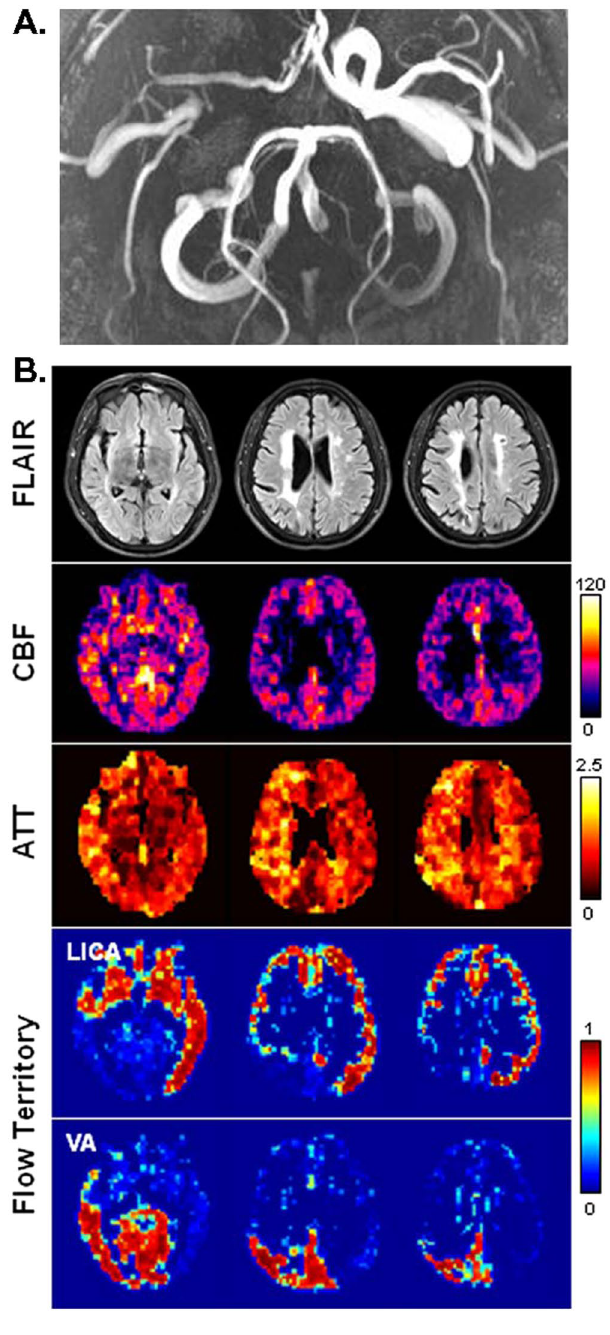
Figure 4. MR images obtained from a 57-year-old male patient with asymptomatic ICA steno-occlusive disease ( > 95% stenosis in the right ICA and 10–30% stenosis in the left ICA). ( A ) Time-of-flight angiography. Projection view from below. ( B ) From top to bottom rows (3 slices are shown in radiological convention): FLAIR images, CBF maps (in units of ml-blood/100 ml-tissue/min), ATT maps (in units of sec), and flow territory maps. Flow territory maps show the membership levels generated by fuzzy clustering, which range from 0 to 1. No contribution from right ICA was extractable. In FLAIR images, there are bilateral confluent periventricular white matter hyperintensities which are larger on the right